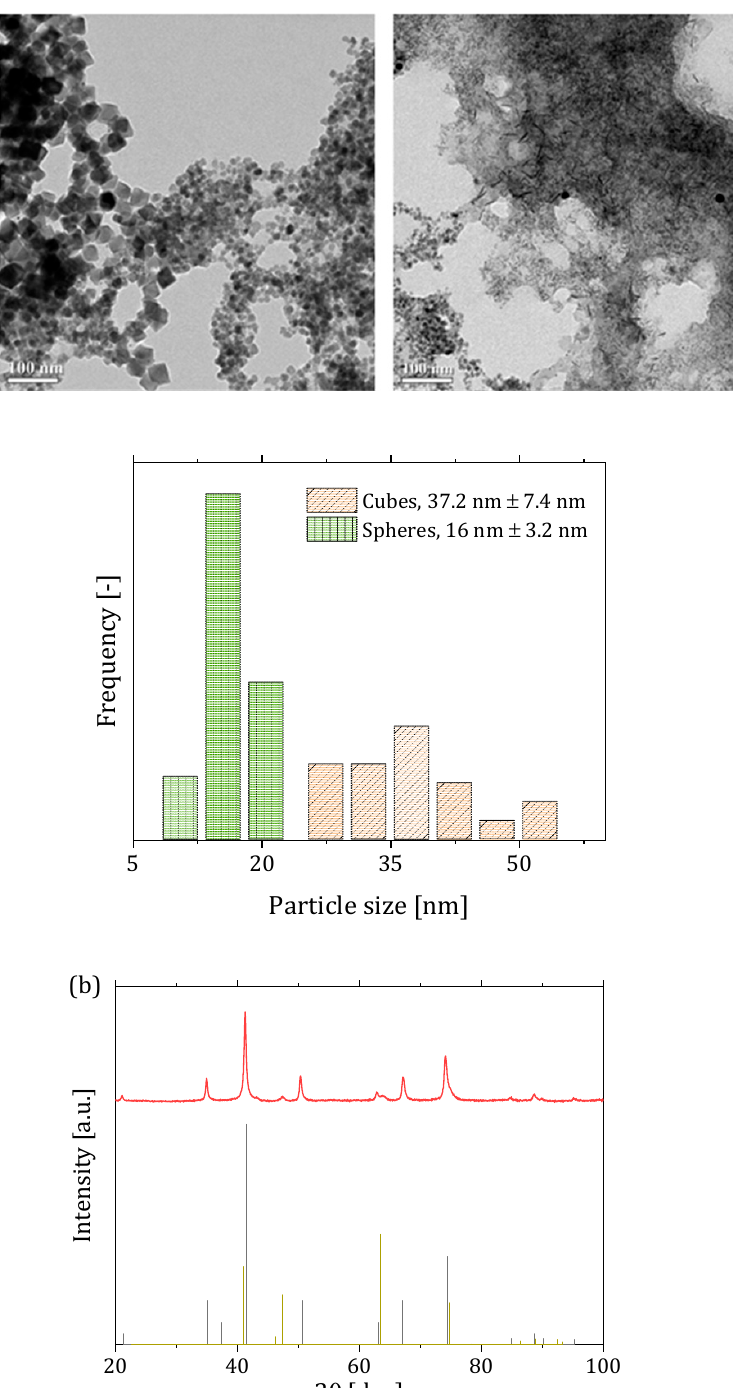
Figure 2. ( a ) Transmission electron microscope (TEM) micrographs of particles obtained from Reactor System 1, showing the presence of three different particle populations, with cuboidal, spherical and nanoflake morphology. Scale bar = 100 nm. The histogram reports the particle size distribution of spherical and cuboidal particles from Reactor System 1. Nanoflake particle size distribution was not determined due to strong aggregation between particles on the grid; ( b ) X-ray diffraction (XRD) pattern for the particles produced using Reactor System 1, showing the two identified phases: magnetite/maghemite (black vertical lines, pdf ref. 03-065-3107) and feroxyhyte (olive vertical lines, pdf ref. 01-077-0247).